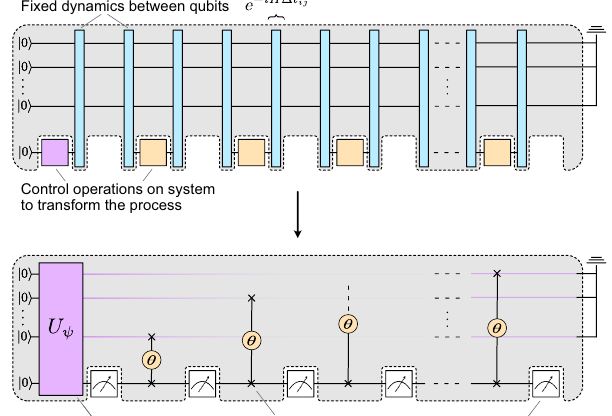
FIG. 4. A complex dynamic sampling problem generated by the Heisenberg interaction on a spin chain. A single-qubit system interacts with a spin chain with fixed Heisenberg coupling, H